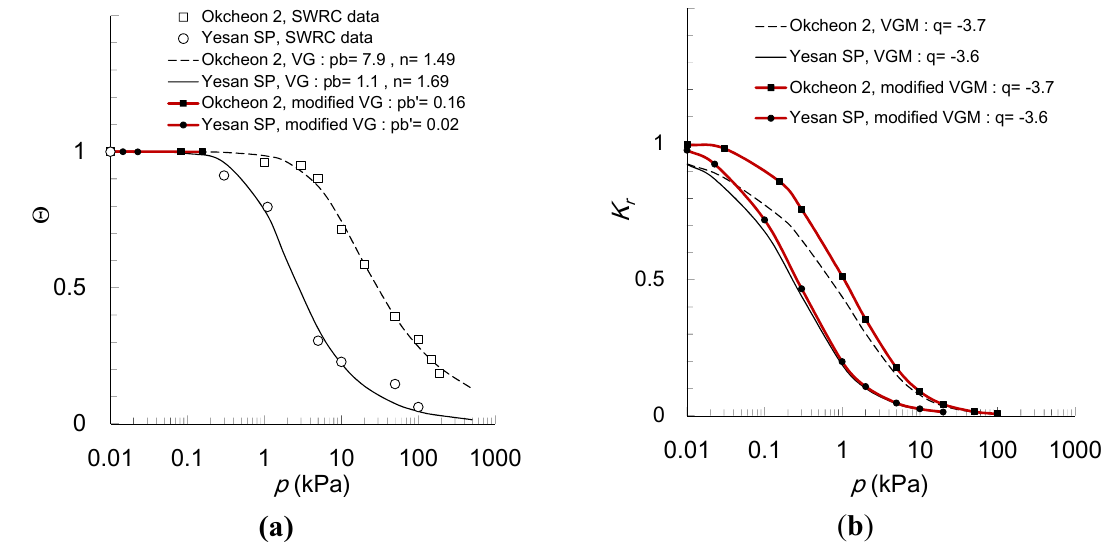
Figure 7. Comparison of the VGM model with the modified model in Group B: ( a ) soil water retention curves (The measured data are shown by points, and the modified VG curve by lines with point when p < p b ʹ ); ( b ) hydraulic